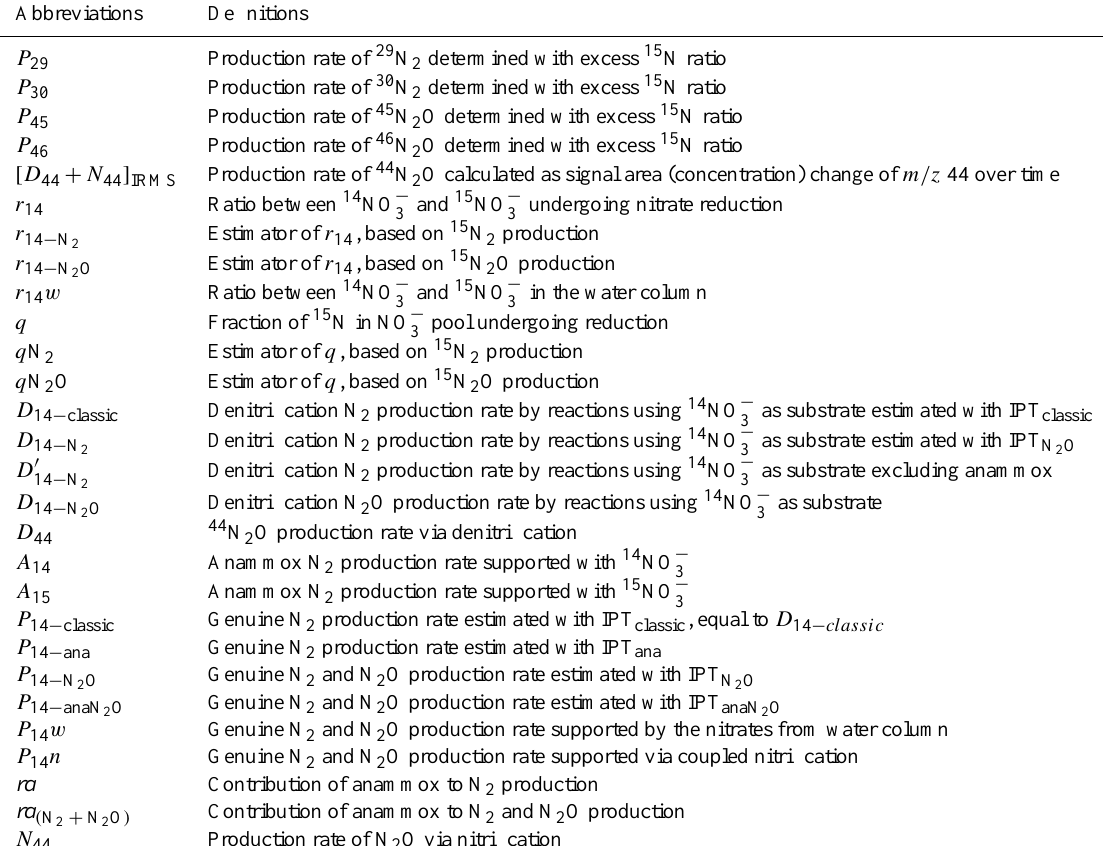
Table 1. List of abbreviations used in